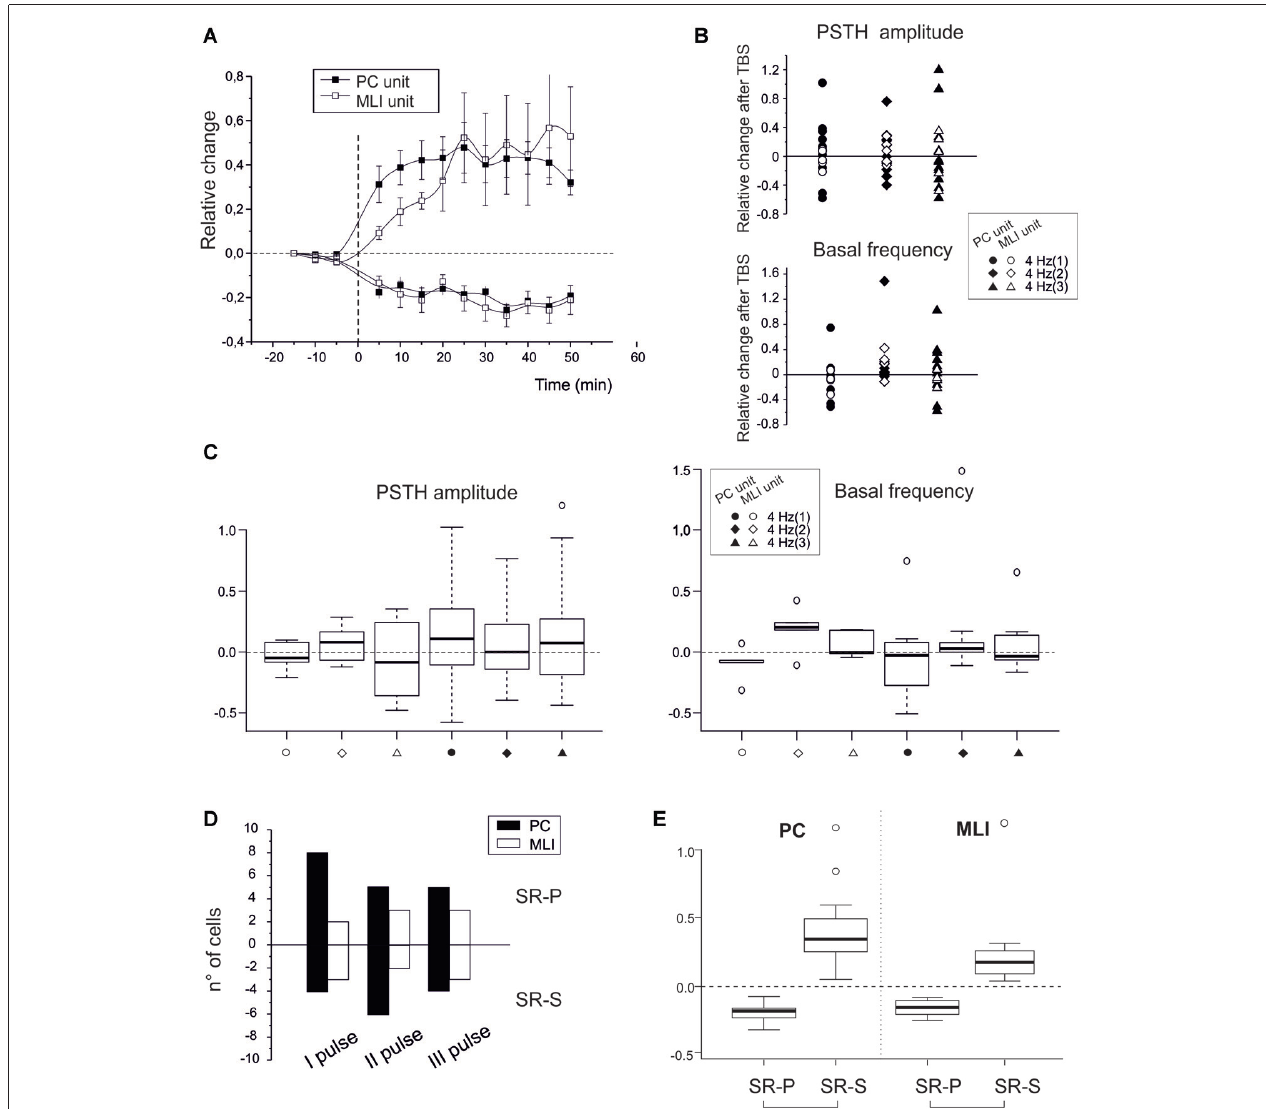
FIGURE 3 | Spike-related plasticity in PCs and MLIs following PF electrical stimulation. (A) Time course of the normalized PSTH peak amplitude changes after PF TBS with singlets, doublets and triplets stimulation. Left, average time course of changes (mean ± MSE) in PCs ( n = 32) and MLIs ( n = 16) grouped depending on whether they made SR-P (18 PCs, 8 MLIs) or SR-S (14 PCs, 8 MLIs). Right, changes in individual units after TBS both for peak PSTH amplitude changes and for basal frequency changes. (C) Boxplot representation and one-way ANOVA on the samples reported in (B) . The Tuckey post hoc test did not reveal any significant differences between conditions. (D) Histogram representing the number of cells showing SR-S or SR-P with TBS protocols using singlets, doublets or triplets. (E) Boxplot representation and one-way ANOVA on the relative change of discharges reported in (A) . The Tuckey post hoc test revealed significant differences between SR-P and SR-S both for PCs and MLI (for numbers, see main